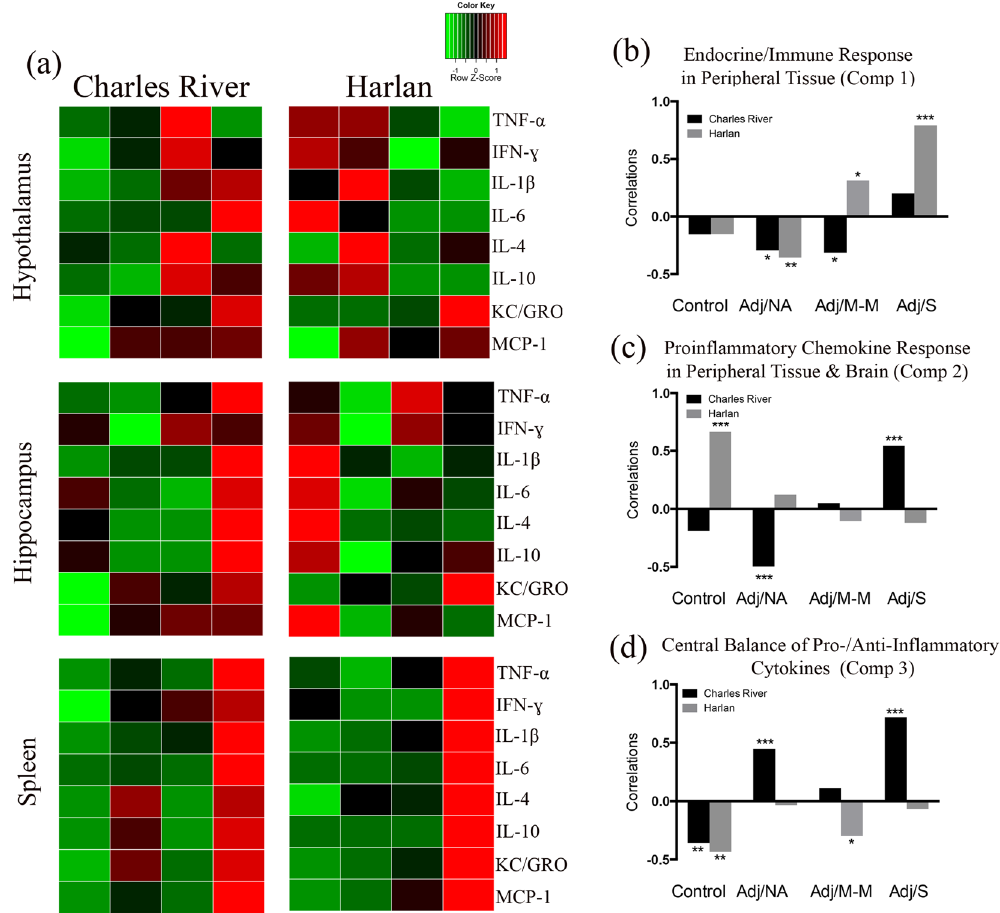
Figure 5. Endocrine/immune activation in response to complete Freund’s adjuvant (CFA) injection. ( a ) Heatmaps showing the overall cytokine response to CFA-injection in the hypothalamus, hippocampus, and spleen. Columns represent severity states (control, Adj/NA, Adj/M-M, Adj/S), split by colony, as indicated. Rows represent mean cytokine levels (z-scored data) by severity state, within each tissue. Colors indicate deviations from the mean of zero, as indicated in the colour key. ( b–d ) Graphical representation of the correlations between the experimental condition (colony, AA severity) and the subjects’ component scores for component 1 ( Endocrine/Immune Response in Peripheral Tissue ), 2 ( Proinflammatory Chemokine Response in Peripheral Tissue & Brain ), and 3 ( Central Balance of Pro-/Anti-Inflammatory Cytokines ) from the CPCA. * p < 0.05; ** p < 0.01; *** p < 0.001. Control: saline-injected; Adj/NA: no clinical signs of AA following CFA injection; Adj/M-M: mild-moderate AA, clinical score ≥ 1, < 8; Adj/S: severe AA, clinical score ≥